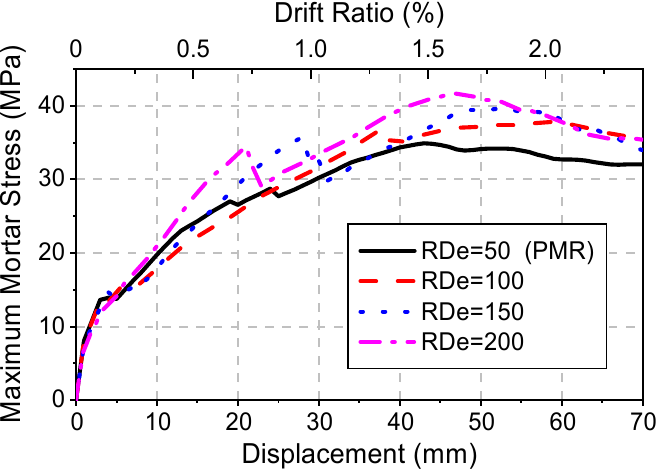
Figure 21. Mortar maximum stress with different recess depths before the displacement of 70 mm.